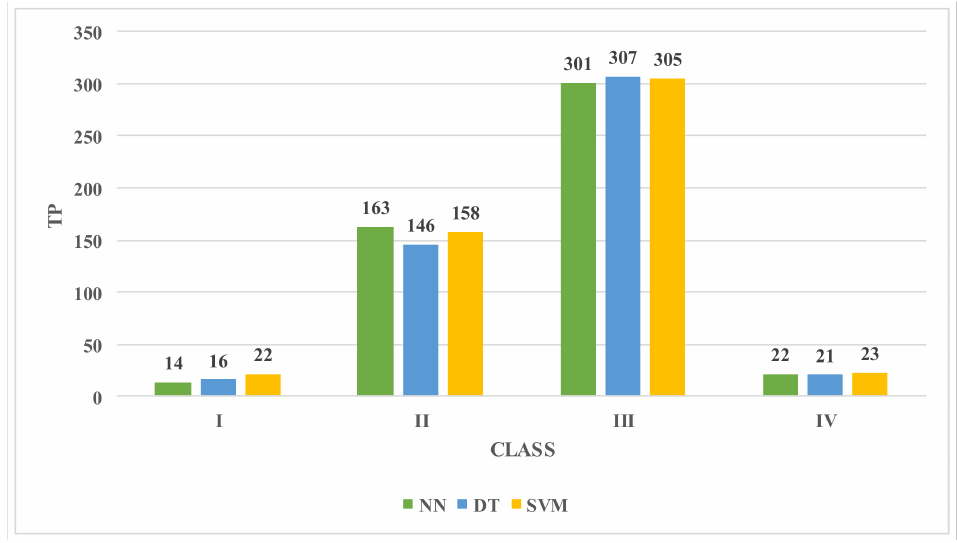
Figure 4. Comparison of TP between NN, DT, and SVM